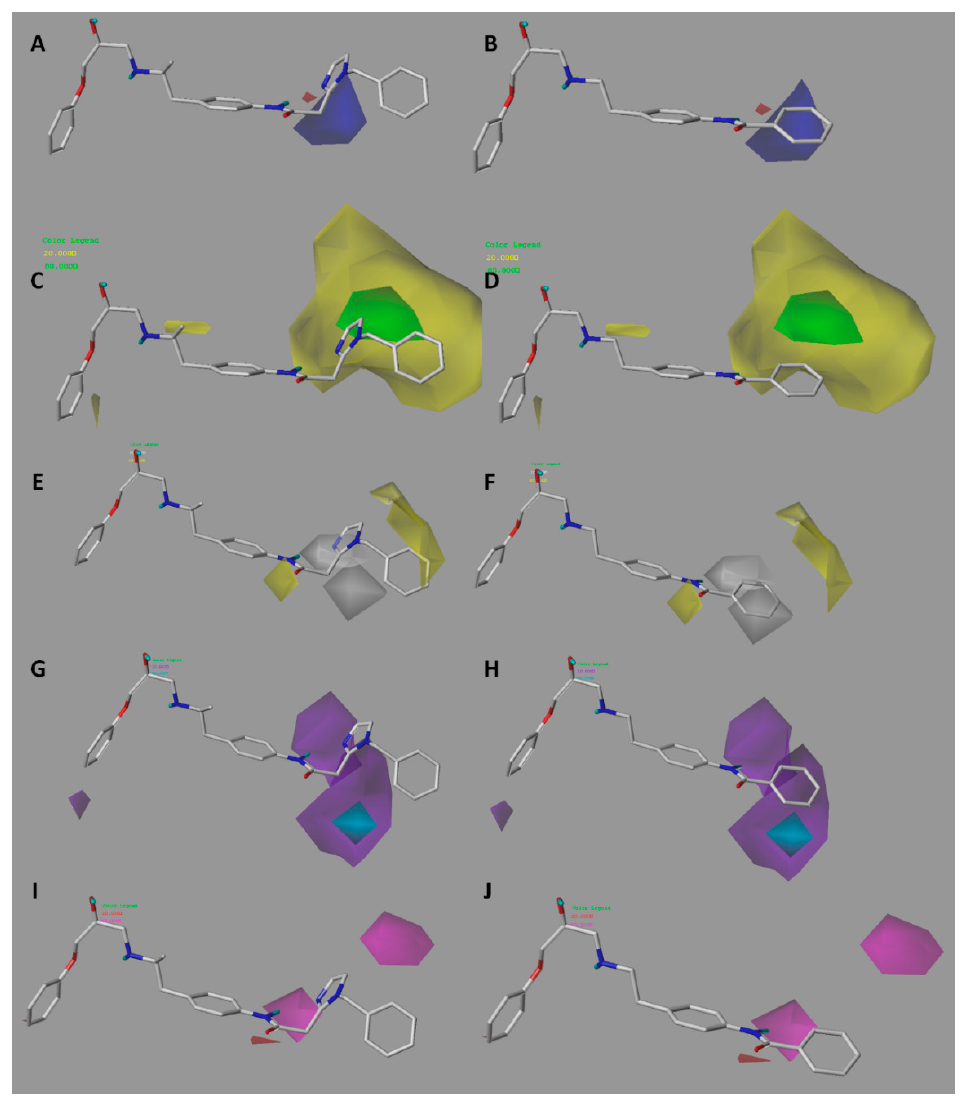
Figure 4. CoMSIA electrostatic ( A , B ); steric ( C , D ); hydrophobic ( E , F ); donor ( G , H ) and acceptor ( I , J ) contour maps around compounds 16 ( left ) and 21 ( right ), the most active and less active of the series respectively. The colors in A – D have the same meaning as in the CoMFA contour maps. Hydrophobic favored areas are in yellow and unfavorable areas in grey ( E , F ). Donor and acceptor favored areas are in cyan and magenta respectively, and donor and acceptor unfavorable areas are in purple and red, respectively ( G – J ). Table 5. The proposed structures of new molecules and their predicted pEC 50 values using the best model. Entry Structure